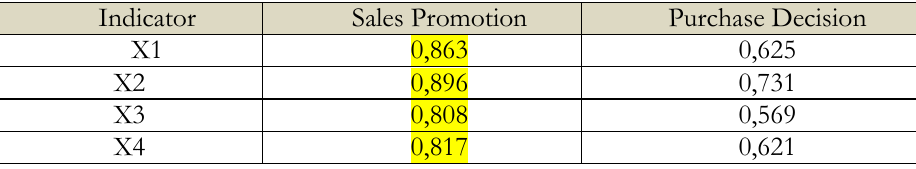
Table 3 Discriminant Validity test results (Cross